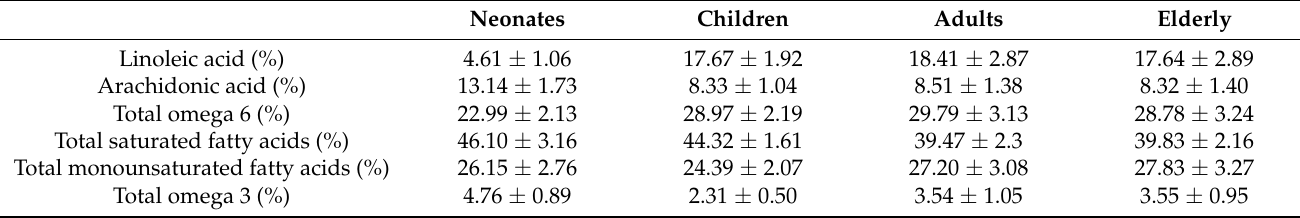
Table 1. Blood omega-6 levels in healthy subjects. Linoleic acid, AA, omega 6, total saturated fatty acid, monounsaturated fatty acids, and total omega-3 levels in human subjects. AA is the second highest fatty acid of the omega-6 series. Data are expressed as percentage of total fatty acids [4]. Neonates Children Adults Elderly Linoleic acid (%) 4.61 ± 1.06 Arachidonic acid